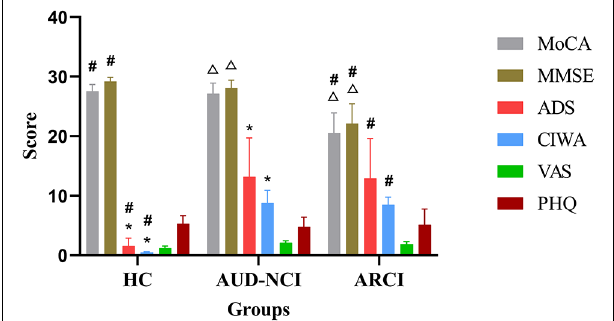
FIGURE 1 | Cognitive assessment scales compared in these three groups. ∗ p < 0.05 HC group vs. AUD-NCI group. # p < 0.05 HC group vs. ARCI group. (cid:52) p < 0.05 AUD-NCI group vs. ARCI group. AUD, alcohol use disorder; NCI, non-cognitive impairment; HCs, healthy controls; ARCI, alcohol-related cognitive